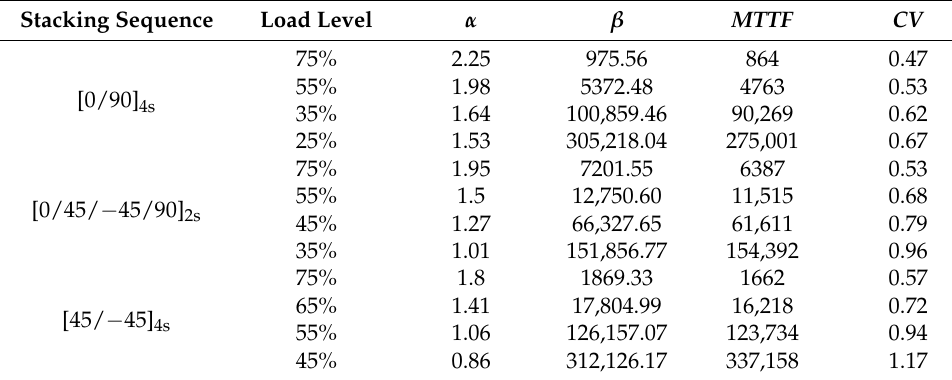
Table 6. Weibull parameters under different load levels.